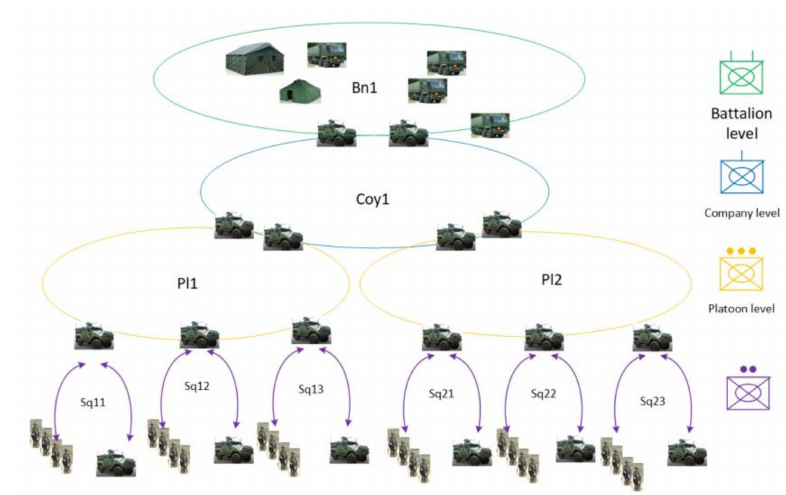
Figure 2. Hierarchical combat